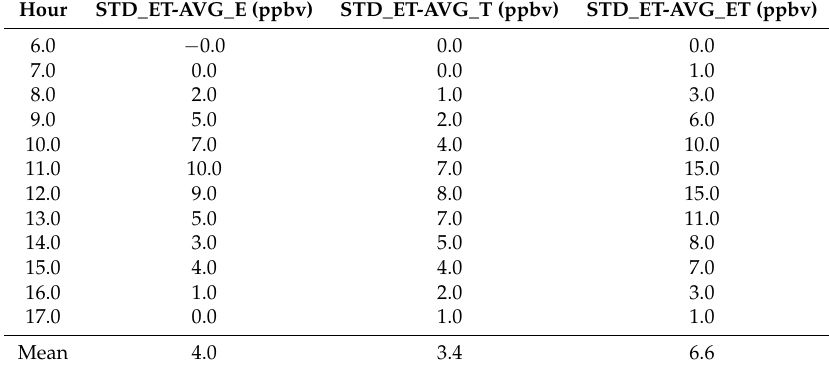
Figure 13. Timeseries of simulated O 3 from the 17 sites for various scenarios on 18 January 2013. Table 3. Table showing differences in ozone (ppbv) for 12 January between 6:00 a.m. and 5:00 p.m. for various scenarios where STD_ET is the run under standard or normal biogenic emissions and temperatures, AVG_E is the run with averaged biogenic emissions, AVG_T is the run with averaged temperatures and AVG_ET is the run with both averaged biogenic emissions and